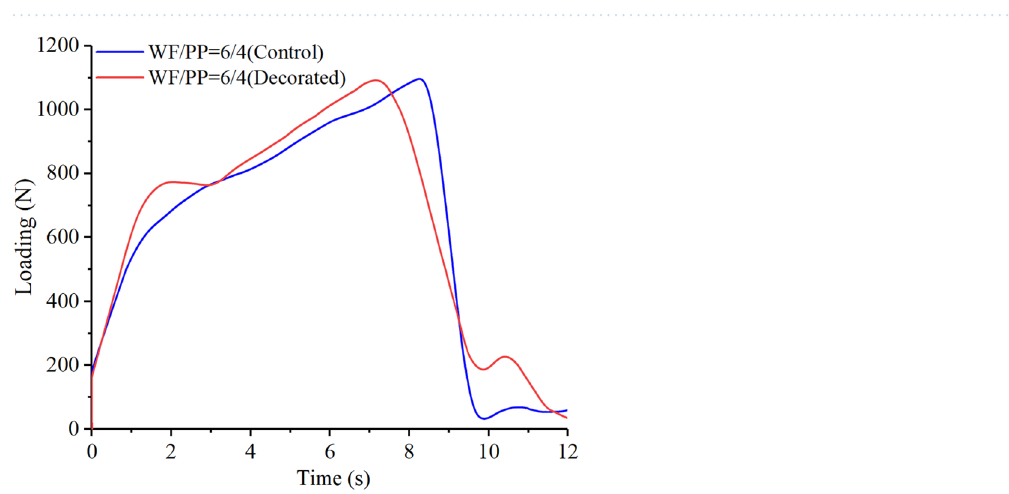
Figure 14. Images of the typical perforation forms of the ( a ) WF/PP = 6/4 (control), ( b ) WF/PP = 6/4, and ( c ) WF/PP = 8/2 composite boards after the low-velocity impact testing.